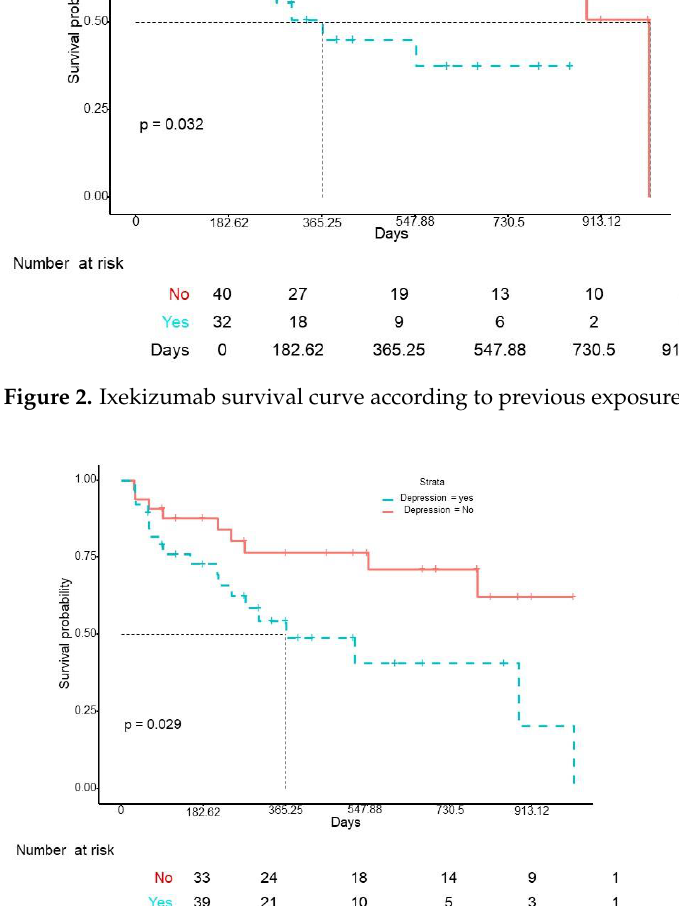
Figure 3. Ixekizumab survival curve according to the presence of depression.